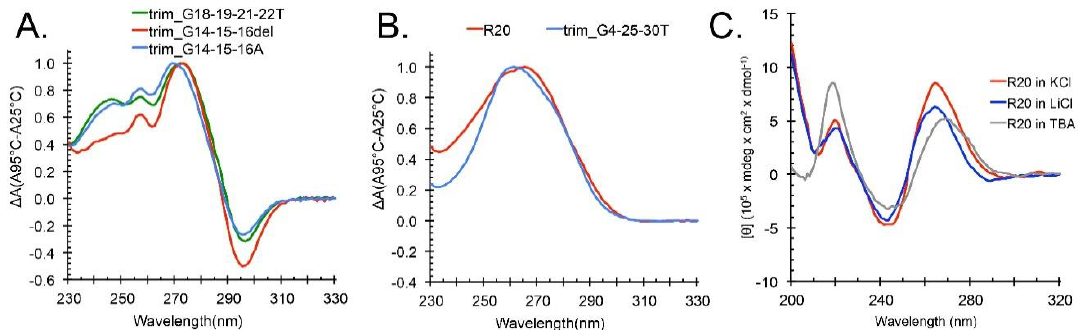
Figure 5. Preliminary mutagenesis of the trim_A5U oligonucleotide. Oligonucleotides were annealed in a bu ff er containing 10 mM TBA pH 7.5 supplemented with 100 mM KCl or LiCl. ( A ) trim_A5U variants with the deletion or substitution of tract II guanines with adenines form G4s. ( B ) trim_G4-25-30T oligonucleotide with point mutations in tracts I, III, and IV and A5U R20 oligonucleotide with a randomized sequence upstream of G-tract II did not form stable G4s. ( C ) G4-characteristic CD spectrum is observed only when A5U R20 oligonucleotides are annealed in the presence of cations, but not in the TBA bu ff er alone.